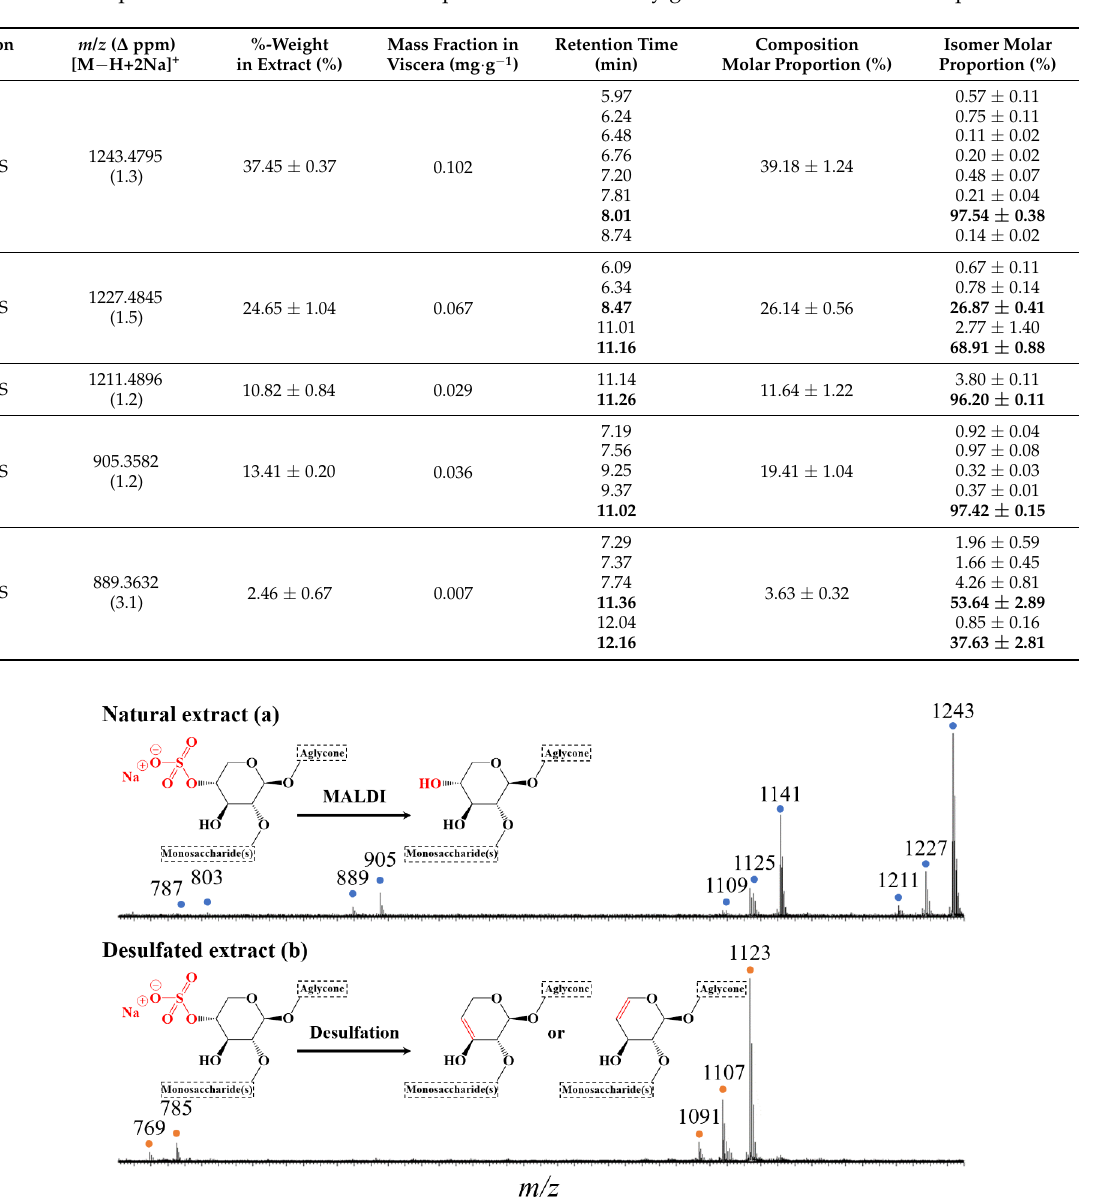
Table 1. Holothuria scabra viscera extract: data collected by MS-based methods. The compositions and the mass error measurements ( ∆ ) were determined by MALDI-HRMS. The Mass fractions (mg · g − 1 of Holothuria scabra viscera powder) of each saponin composition were determined based on the LC ion signal intensity ratios, with Hederacoside C as an internal standard. Note that the MALDI-desulfated saponins are not considered in the present table that only gathers the natural extract saponins.